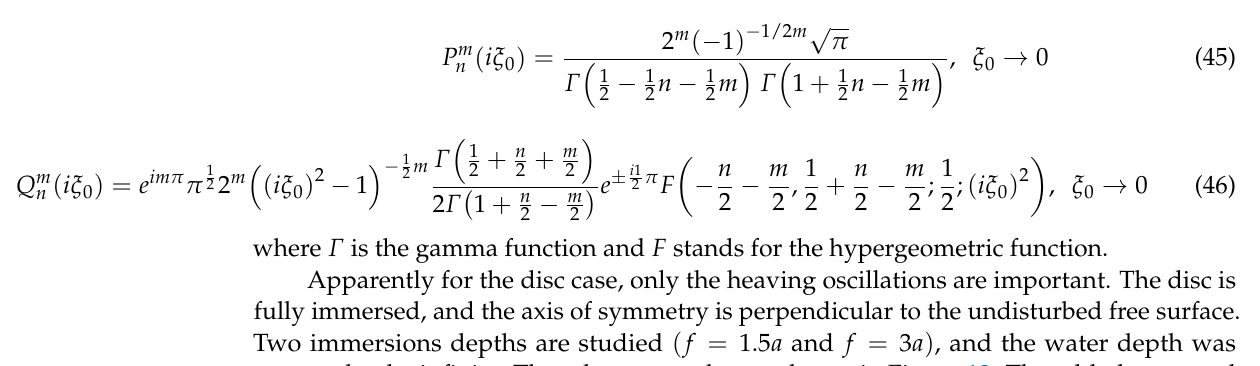
Figure 12. ( a ) An image of an axisymmetric disc; ( b ) A 2D schematic of the problem in the 𝑥 − 𝑧 plane. The whole formulation described in the aforementioned sections remains the same.